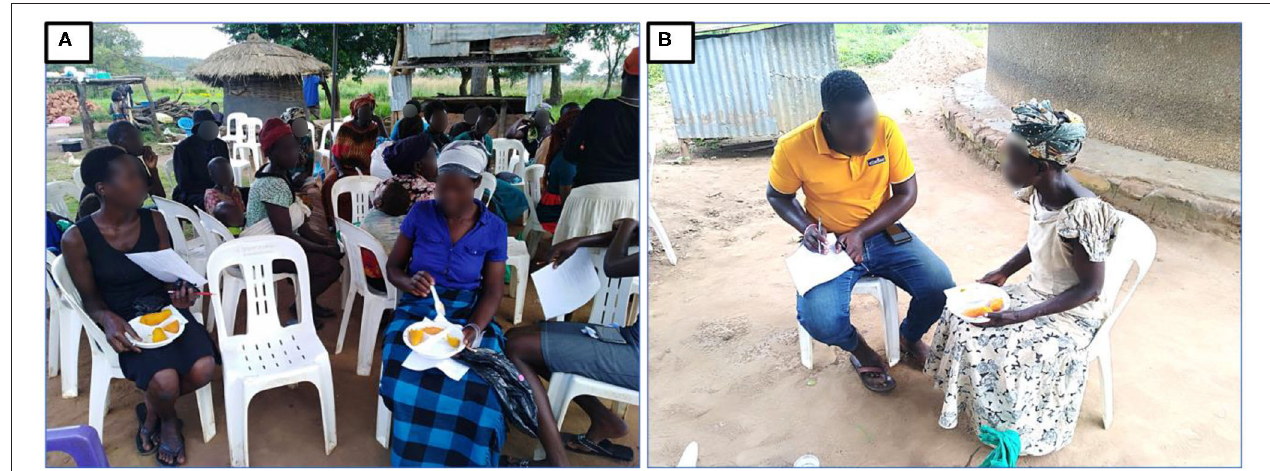
FIGURE 2 | (A) Community members in Gulu (northern Uganda) gathered for the tasting of boiled sweetpotato. (B) Members of the community who could not read or write were assisted by translators to complete the questionnaires (all pictures were taken with consent from participants for research purposes).